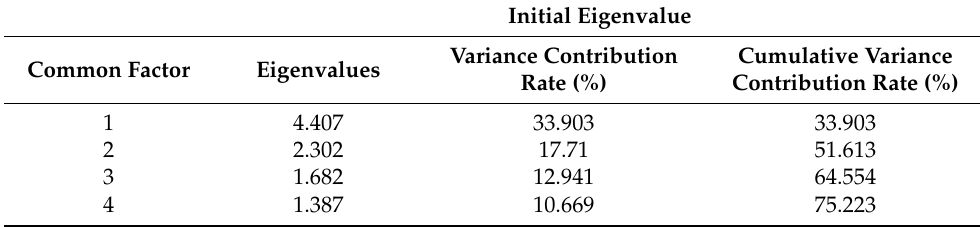
Table 2. Total variance